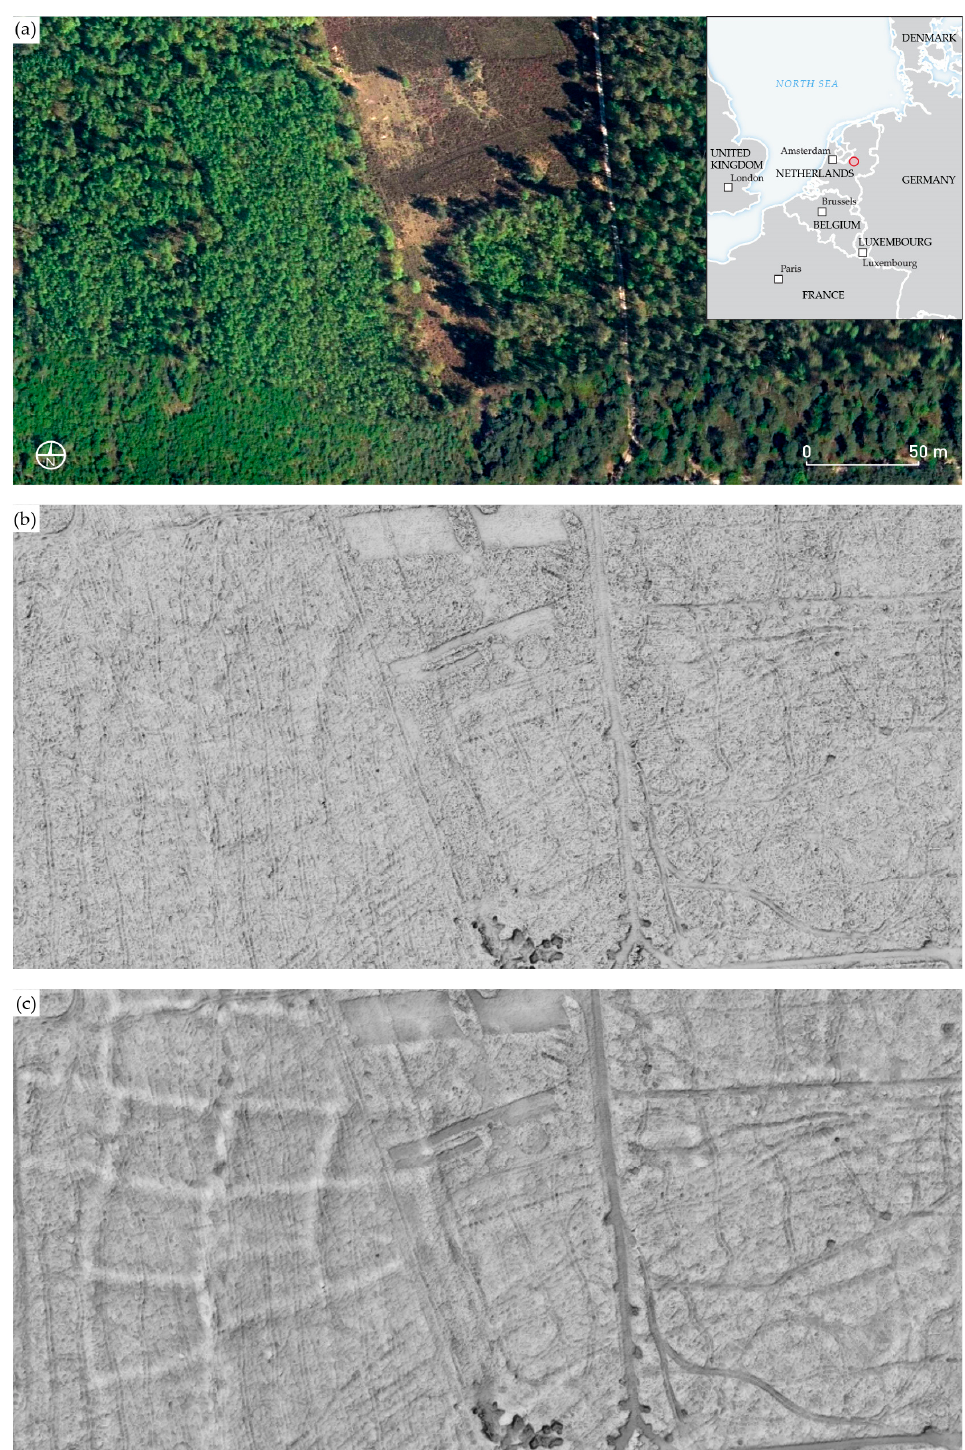
Figure 4. The Celtic fields on the Veluwe in central Netherlands as seen on ( a ) an orthophoto image (Landelijke Voorziening Beeldmateriaal 2018). ( b ) The combined visualization with default settings fails to portray the broader, very subtle features on flat terrain. ( c ) Changing the settings for sky-view factor and openness to include a wider area while disregarding the proximity (e.g., setting the search radius from 5 m to 10 m while disregarding the first 4 m) makes such structures very distinct. 0.5 m resolution ALS data © PDOK.